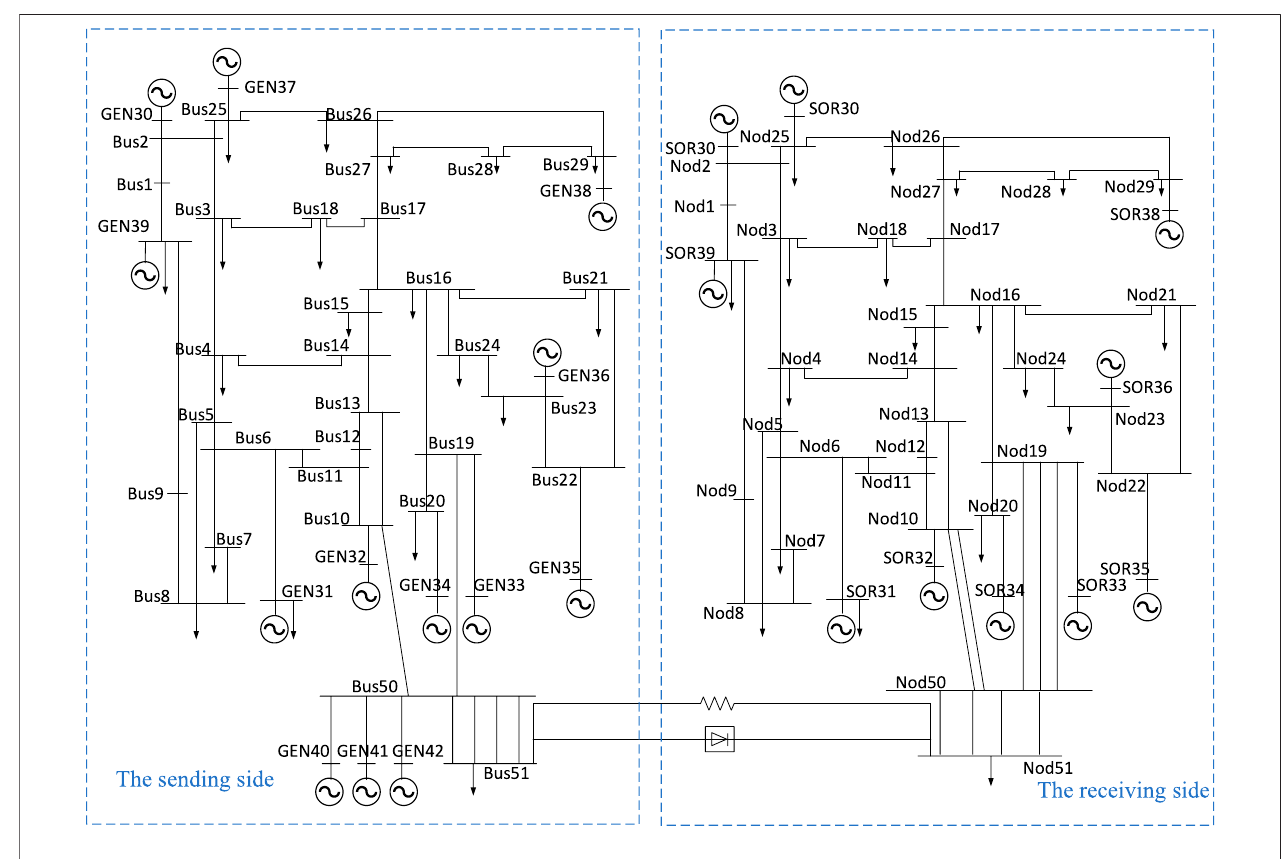
FIGURE 2 | The two-area network model for AC/DC parallel transmission.